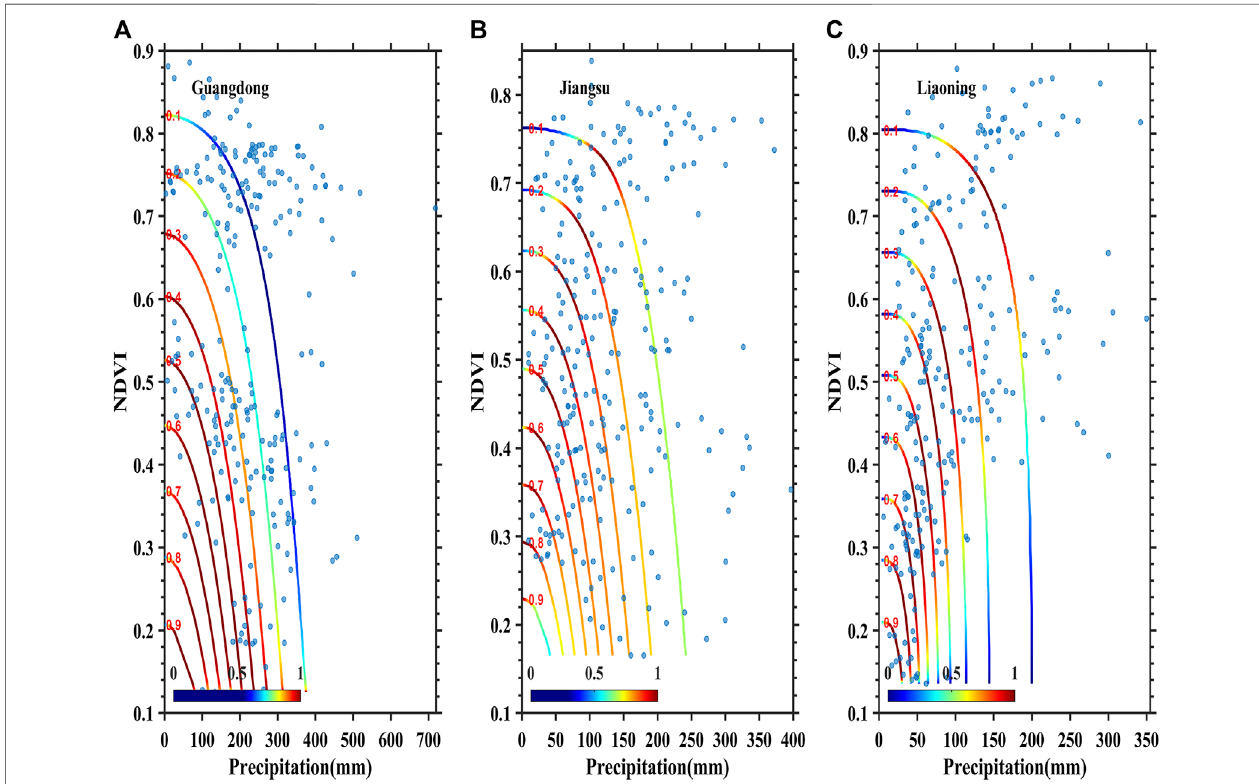
FIGURE 8 | Survival copulas of precipitation-normalized difference vegetation index (NDVI) in Guangdong, Jiangsu, and Liaoning.